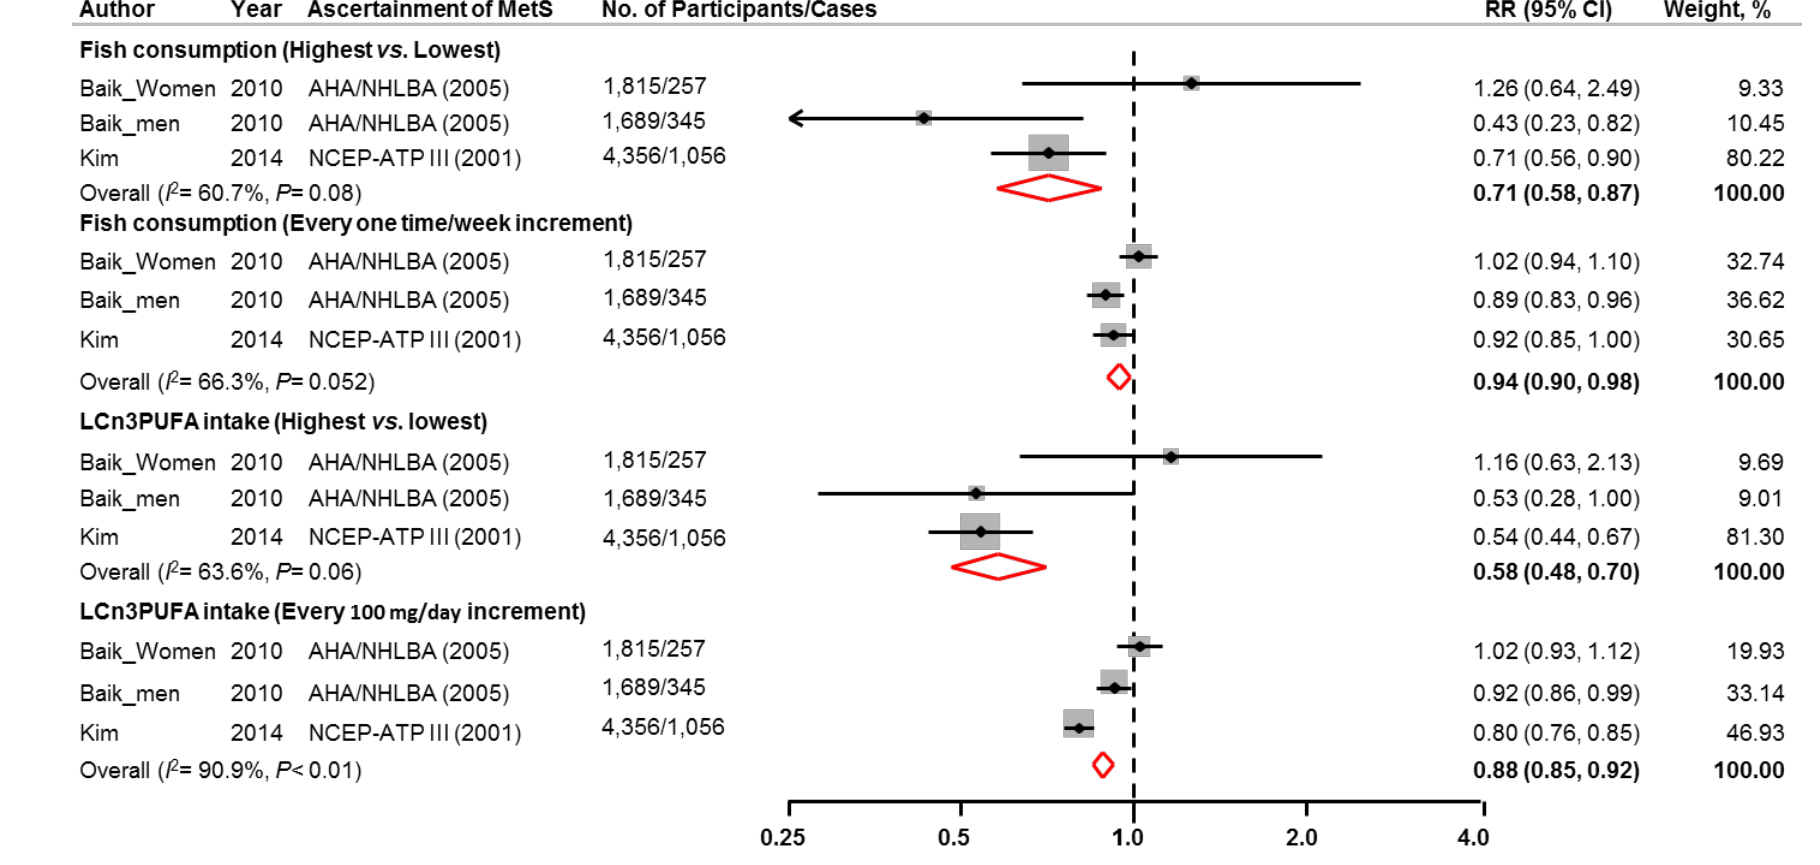
Figure 2. Multivariable adjusted RRs and 95% CIs (horizontal lines) for incidence of metabolic syndrome from prospective cohort studies. The pooled estimates (diamond data markers) were obtained using fixed-effects models. The dots indicate the adjusted RRs by comparing the highest to the lowest category of fish or LCω3PUFA intake or every 1 serving/week increment in fish consumption or 100 mg/day increment in LCω3PUFA intake. The size of the shaded square is proportional to the percent weight of each study. CI: confidence interval; RR: relative